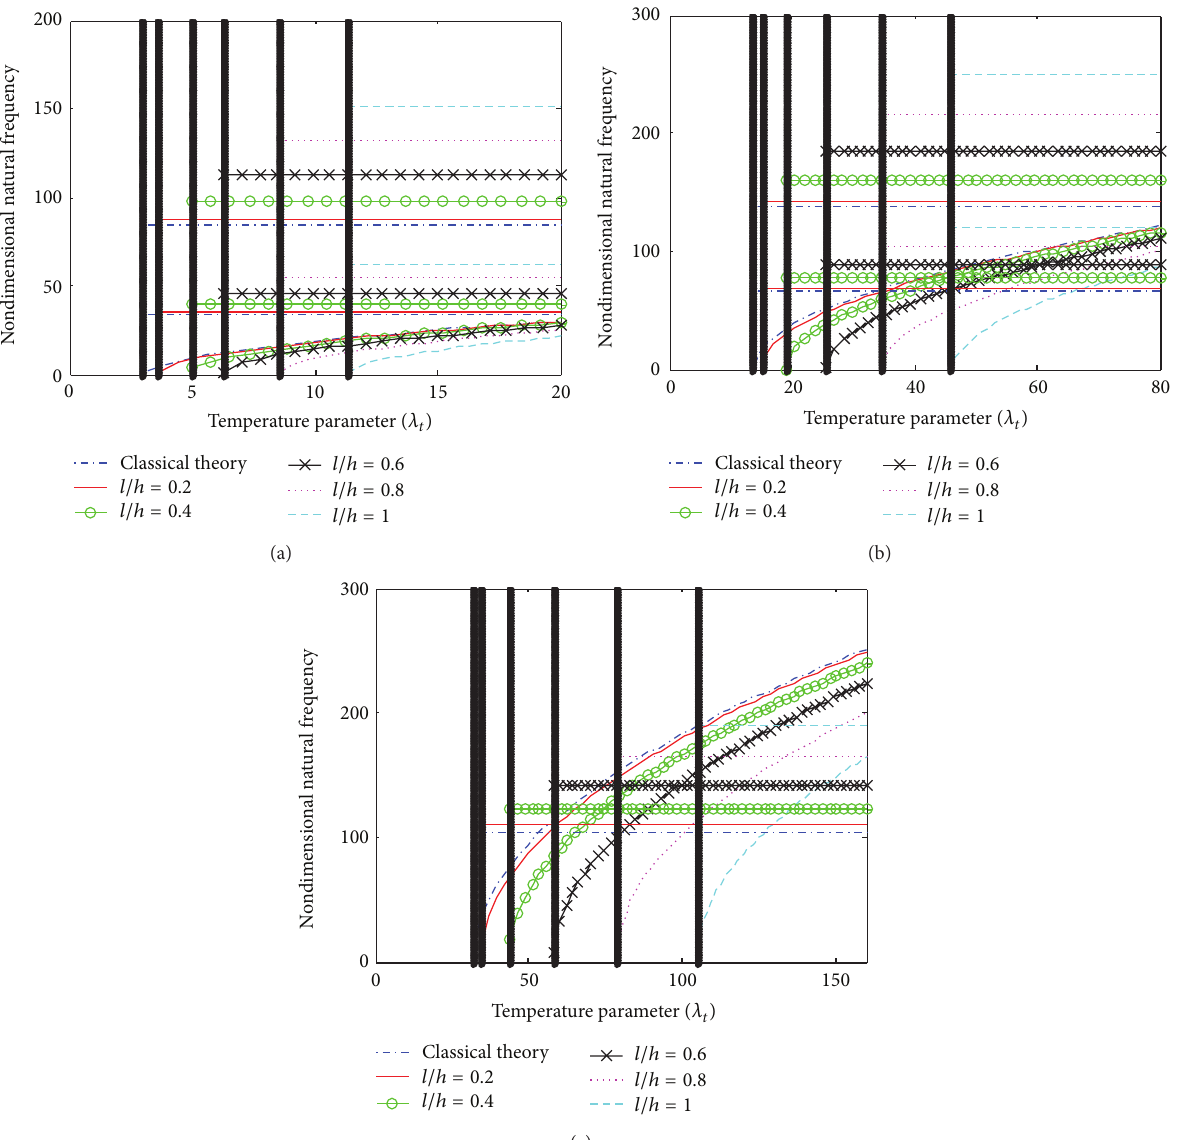
Figure 13: Variation of the nondimensional natural frequency of vibration around the (a) first, (b) second, (c) third buckling mode with the temperature parameter for a simply supported-simply supported FG beam with different values of 𝑙/ℎ ( 𝑘 = 1 , 𝐿/ℎ = 40